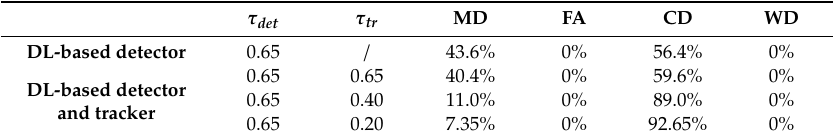
Table 6. DL-based detector vs. DL-based detector and tracker performance as a function of τ tr ( τ det = 0.65). FT3-A composed of 381